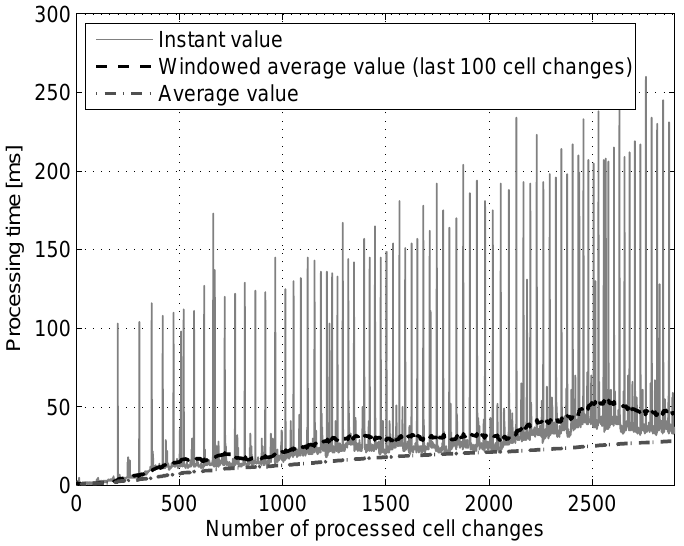
Processing time spent by a mobile phone for processing each new cell and estimating the most probable next location using Active LeZi and PPM